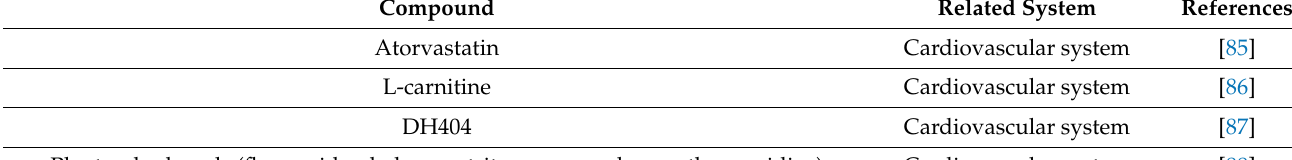
Plant polyphenols (flavonoids, chalcones, triterpenes, and